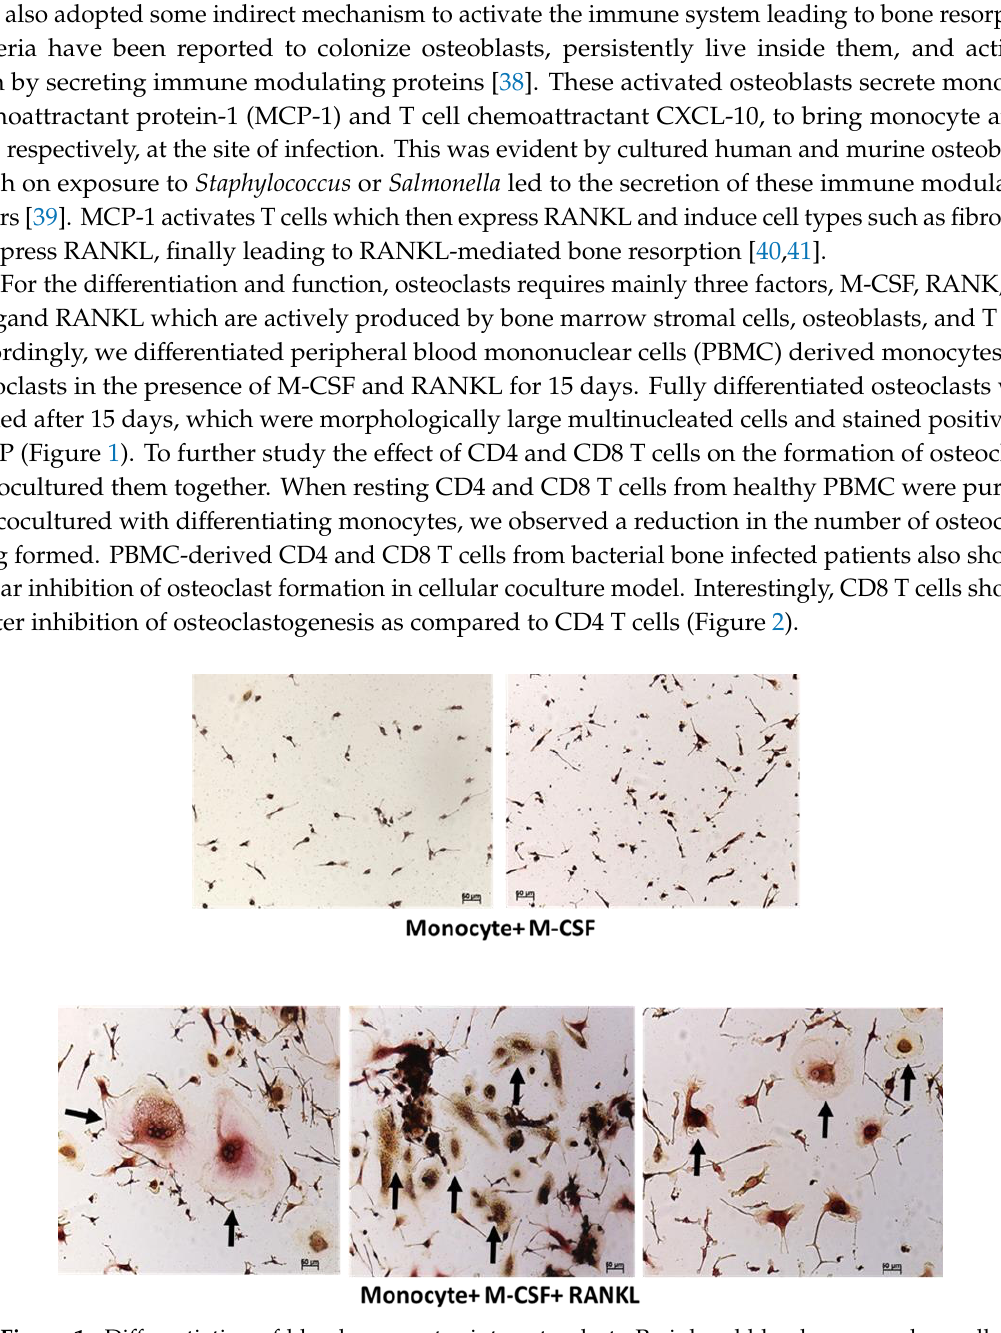
Figure 1. Di ff erentiation of blood monocytes into osteoclast. Peripheral blood mononuclear cells (PBMCs) were isolated from blood of healthy donors by ficoll separation and monocytes were then purified from PBMCs. Purified monocytes were cultured for 15 days in the presence of macrophage-colony-stimulating factor (M-CSF) with or without receptor activator of NF- κ B ligand (RANKL). Finally cells were stained for tartrate-resistant acid phosphatase (TRAP), an enzymatic marker for osteoclast identification. Cells were visualized using a Zeiss light microscope at 10 × resolution. Addition of RANKL to the culture medium led to the di ff erentiation of monocytes into multinucleated large sized pink colored osteoclasts. Black arrows indicate